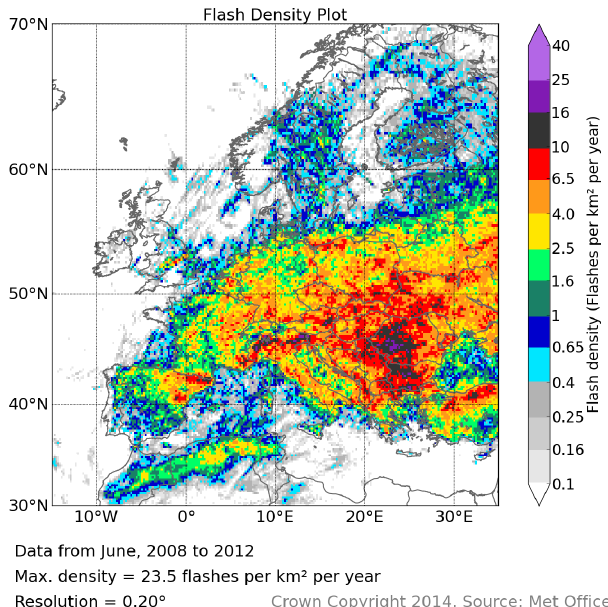
Fig. 8. Detected lightning flash density for April.